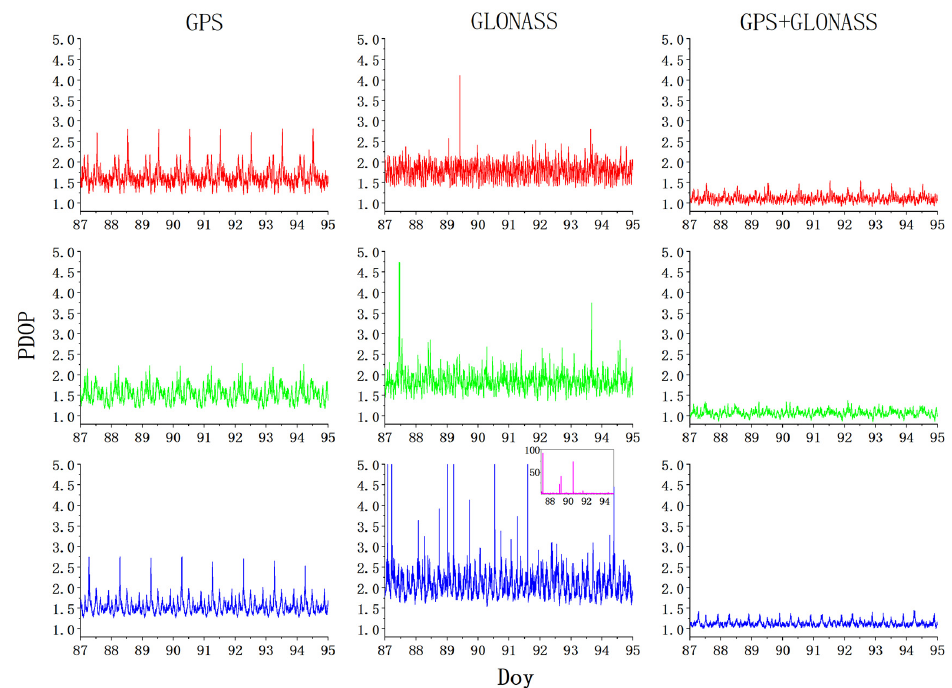
Figure 7. The PDOP of GPS, GLONASS, and GPS+GLONASS in the high (red), middle (green), and low (blue) latitude networks (The GLONASS PDOP for the low latitude network exceed the coordinate threshold, and the small picture in the upper right corner with the rose thread shows the full view of the PDOP).